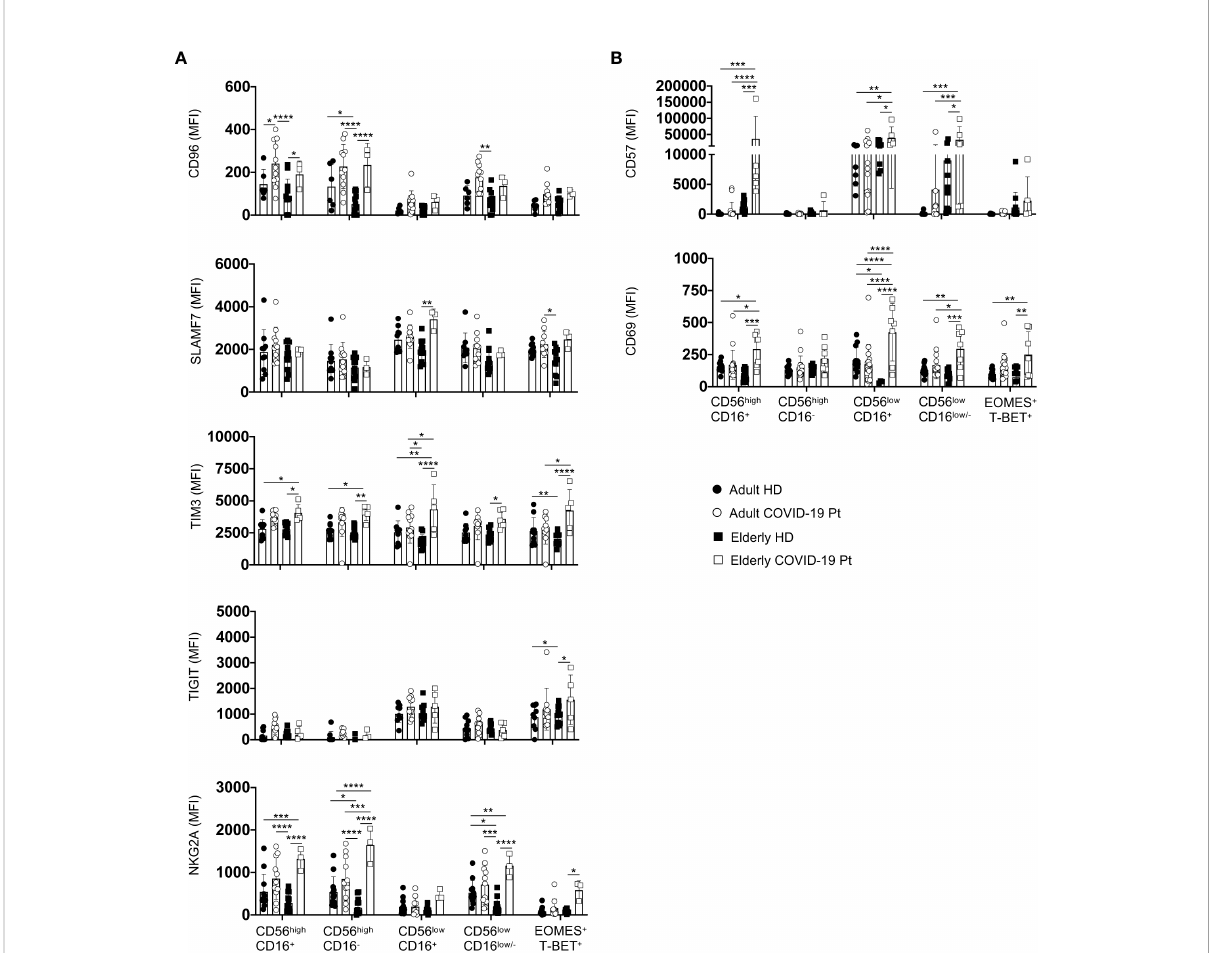
FIGURE 8 Receptor prolife of adult and elderly NK cell subsets. Expression levels of inhibitory (A) and activation/maturation (B) markers on NK cell subsets in adult and elderly COVID-19 patients alongside healthy controls early after hospital admission. MFI median values ± SD for each marker are shown. * p< 0.05, ** p< 0.01, *** p< 0.001, **** p< 0.0001. Two-way analysis of variance (ANOVA) Tukey ’ s multiple comparisons test and One way ANOVA Kruskal-Wallies test multiple